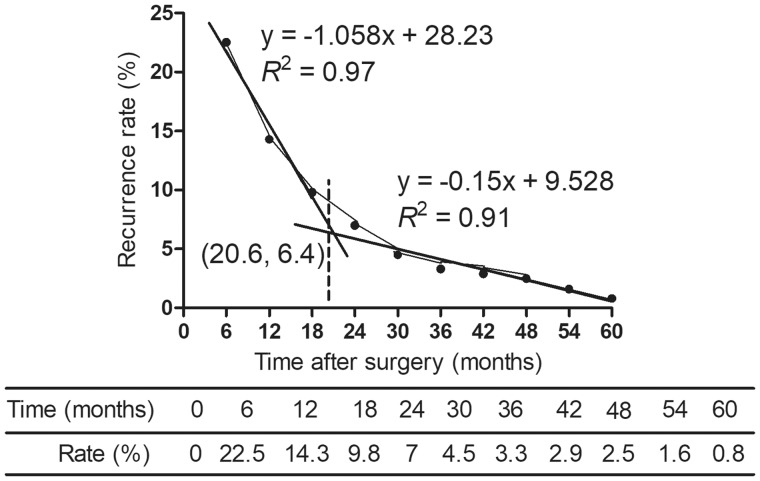
Determination of the optimal cutoff value for early and late recurrence of type IV perihilar cholangiocarcinoma (pCCA). Recurrence was divided into two periods according to the slope of the curves identified with linear regression. The functions of the two straight lines were y = –1.058x + 28.23 and y = –0.15x + 9.528, respectively. The intercept point of the two lines was 20.6 months, thus 21 months was defined as the cutoff to distinguish early from late recurrence for type IV pCCA.